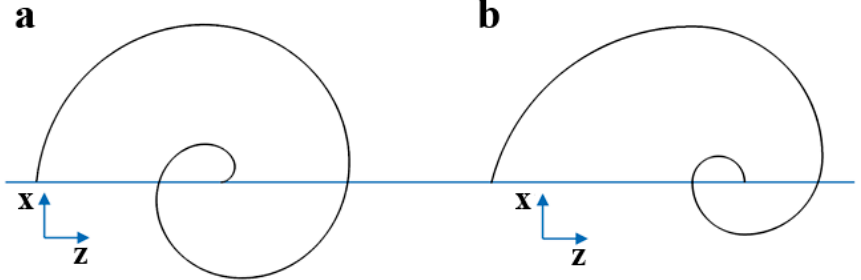
Figure 2. Fibonacci spiral (not to scale). Each square has side lengths referring to the Fibonacci sequence.